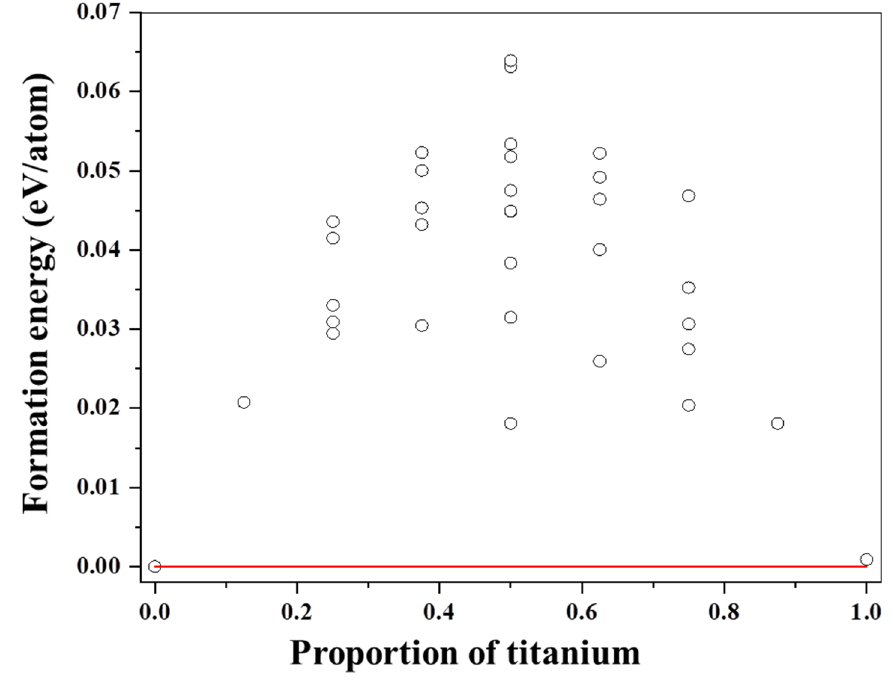
Figure 4. Generation energy of (Ti y Zr 2 − y )Fe on first-principles calculation plus CE. The red solid line represents the zero formation energy.